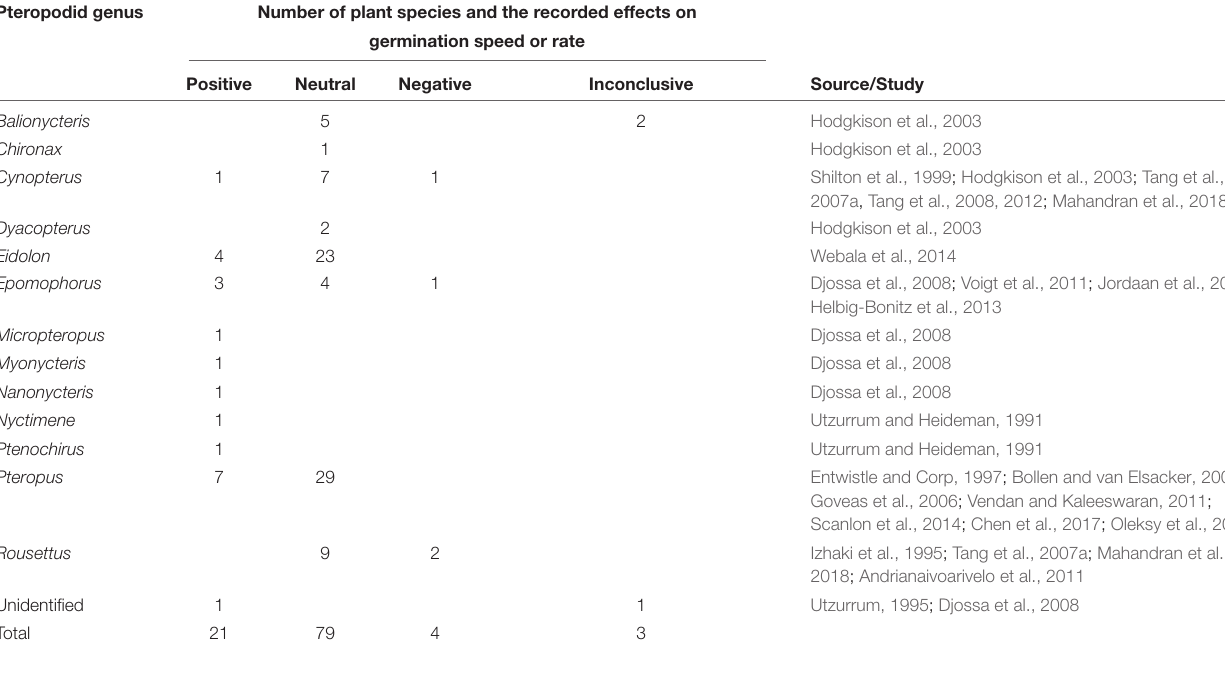
TABLE 5 | Summary of results of germination tests on seeds dispersed by pteropodids. Pteropodid